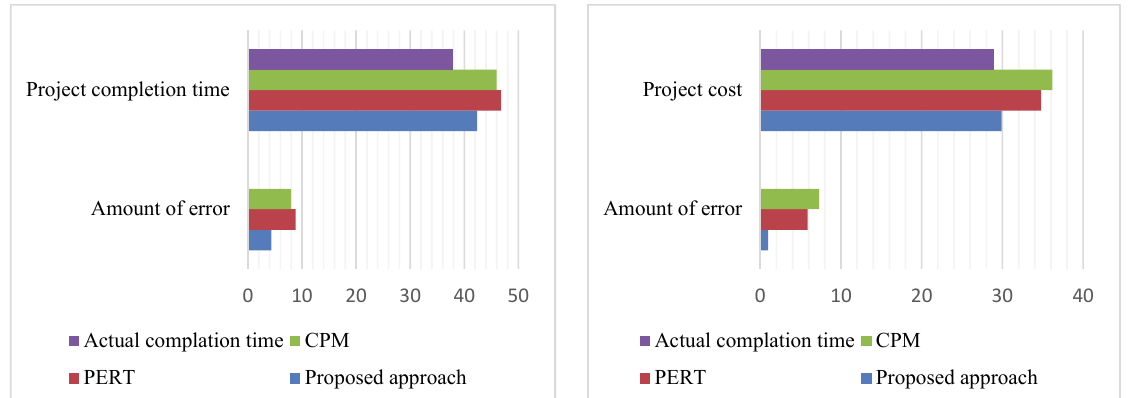
Fig. 2. Comparing the performance of methods for estimat- ing durations